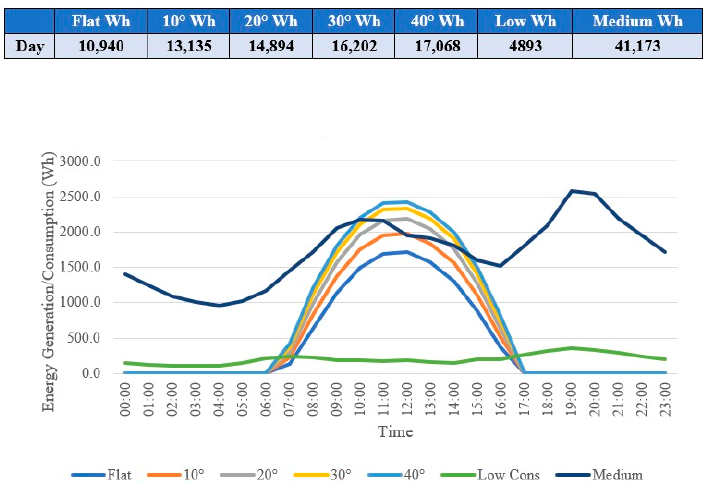
Figure 7. Comparison between hourly electricity generation of a 3 kWp PV system and the patterns of low- and medium-consumption households for a south-facing system in February.